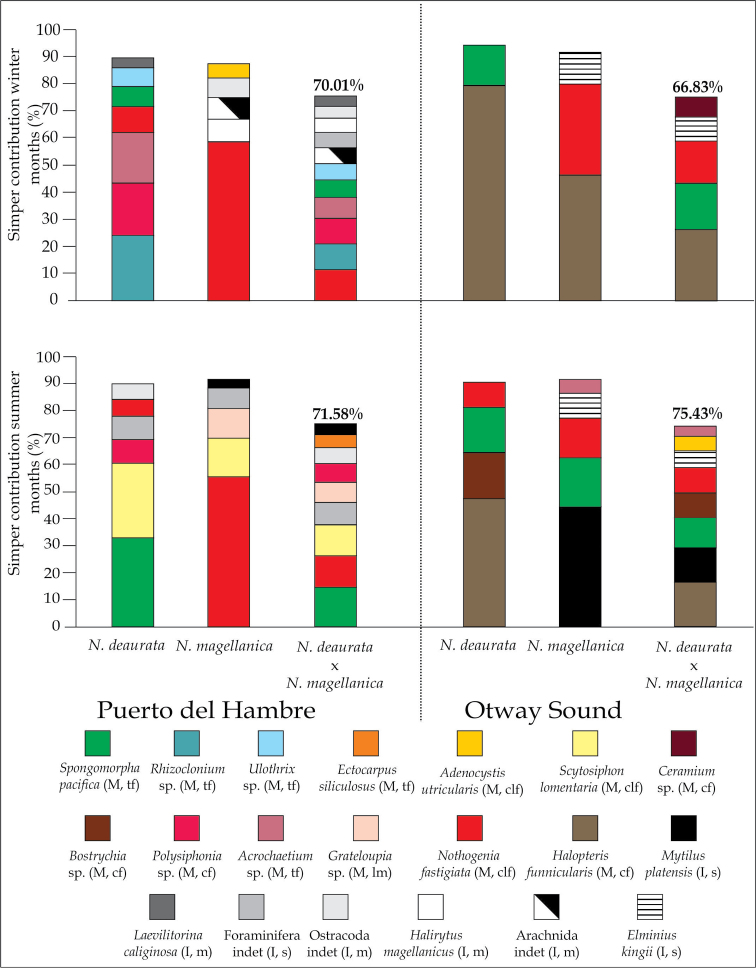
Percentage contribution SIMPER of items in the gut contents of the Nacella species in Puerto del Hambre and Otway Sound for the winter and summer months. The contribution limit was 90% of the total dietary composition. SIMPER analysis shows the dissimilarity between the species of Nacella in the two localities (average dissimilarity in bold and on the bar). The contribution limit was 75% of the total dietary composition. M = Macroalgae (with colours) and I = Invertebrates (with grey scale). Structural hardness of the thallus for macroalgae: th = thin filaments, cf = corticated filaments, clf = cylinder-like form and lm= leathery macrophyte. Functional group for invertebrates: s = sessile and m = mobile.